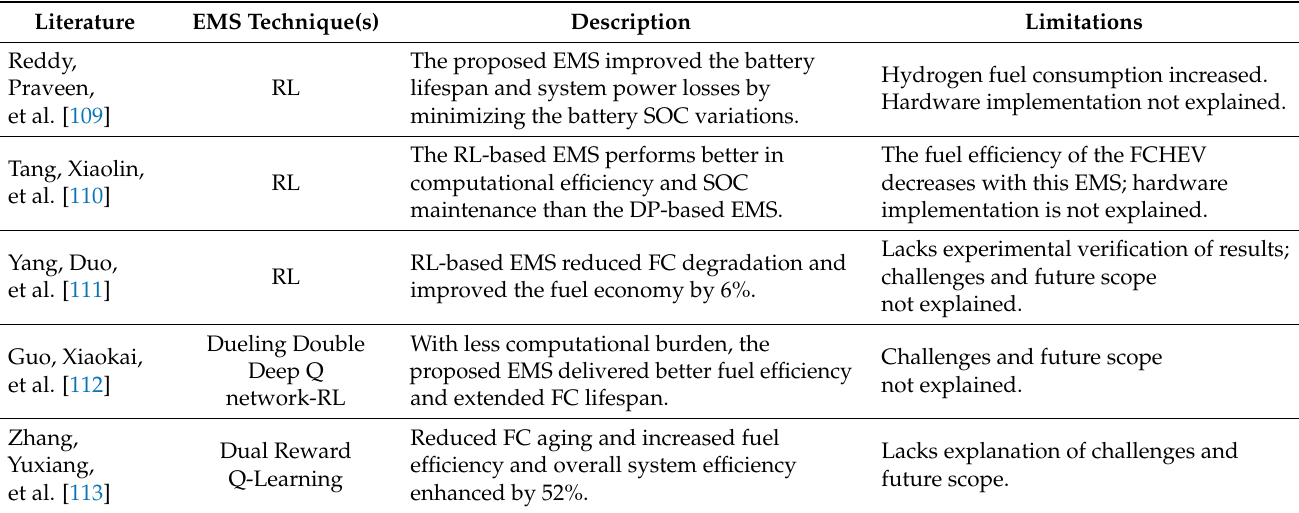
Table 12. Summary of the latest literature related to learning-based